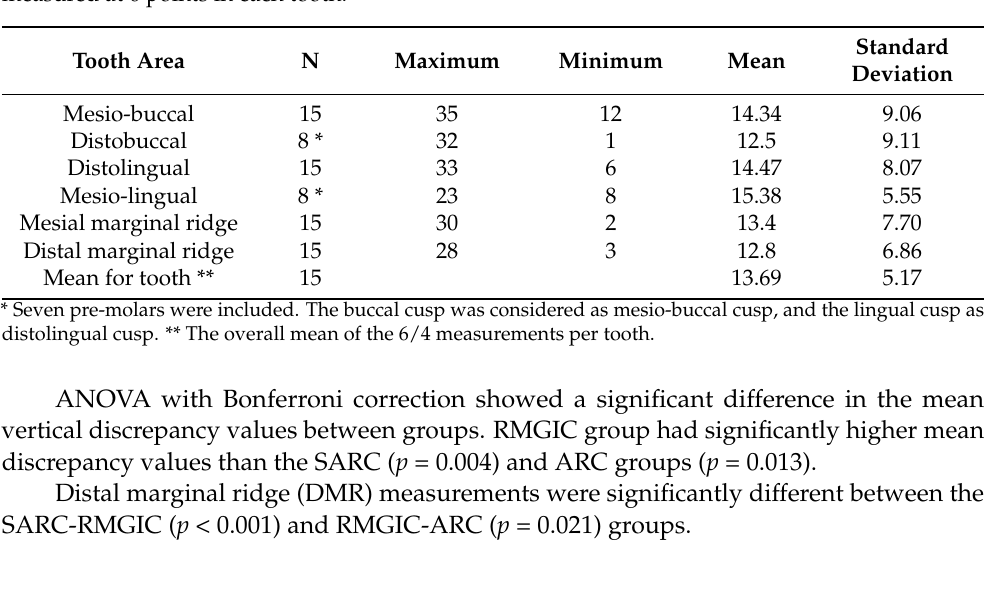
Table 3. Occlusal vertical discrepancies ( µ m) of crowns in adhesive resin cement (ARC) group measured at 6 points in each